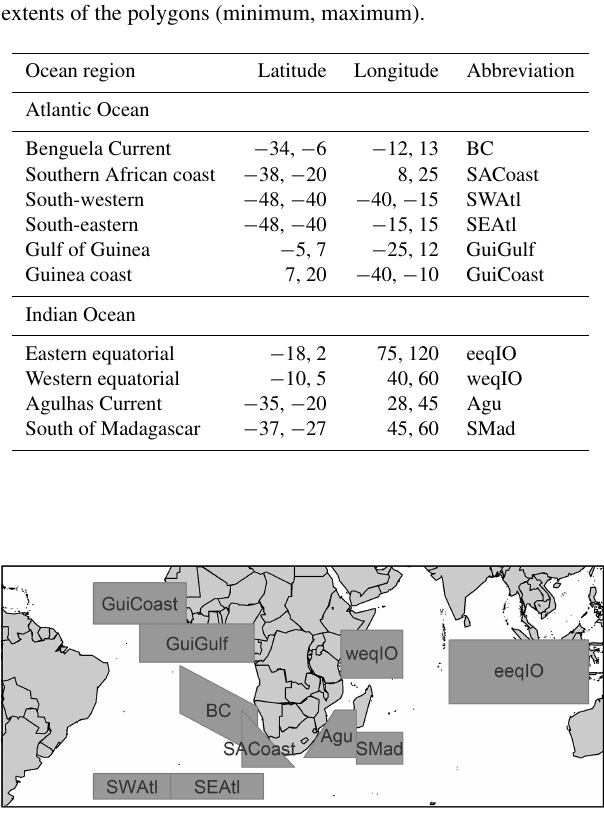
Figure 6. Regions of customised SST indices. Predictor region ab- breviations are listed in Table